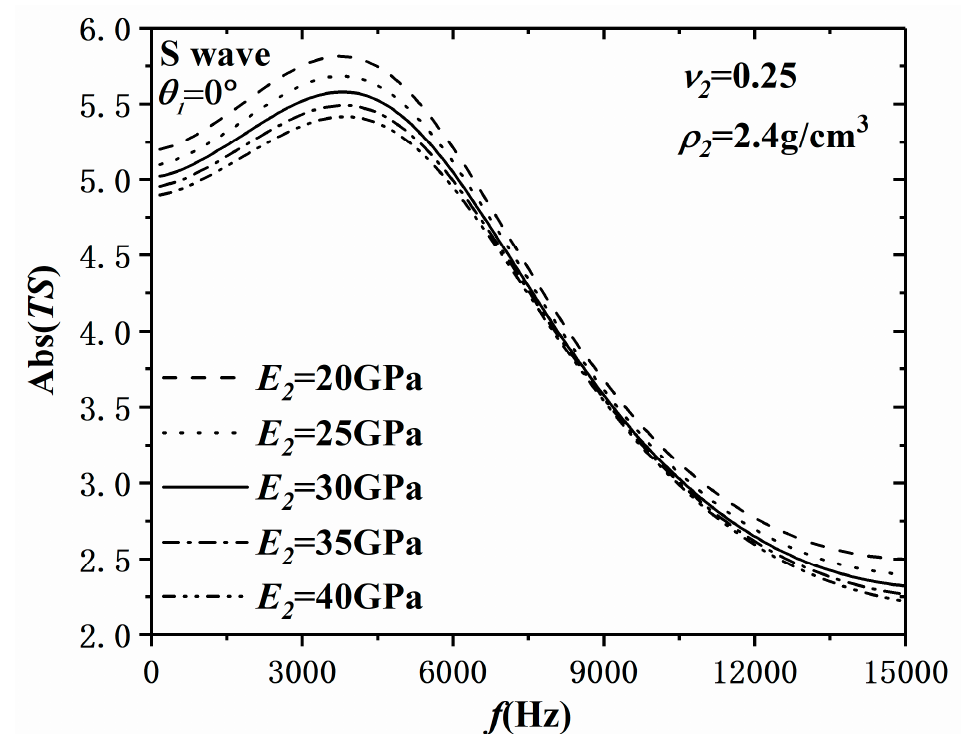
Figure 7. Influence of the Young’s modulus of the expansive grout on theoretical amplitude spectrum of gauge combination TS for the incident S wave. Table 6. Influence of the Young's modulus of the expansive grout on theoretical amplitude spectrum 219 of gauge combinations FS and TS for the incident S wave. 220